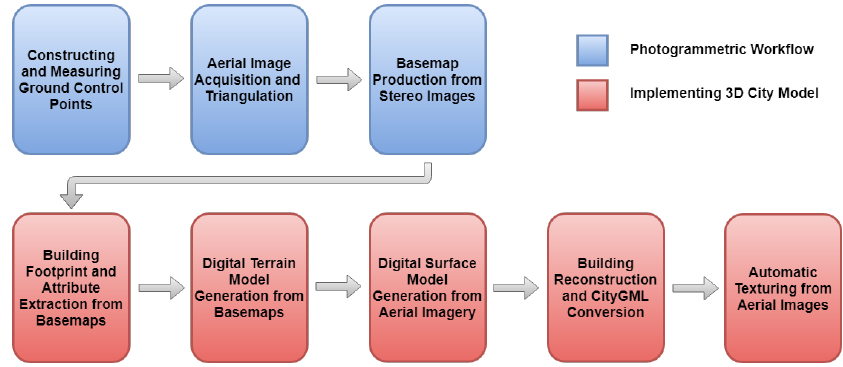
Figure 4. Overall workflow of 3D city model implementation.